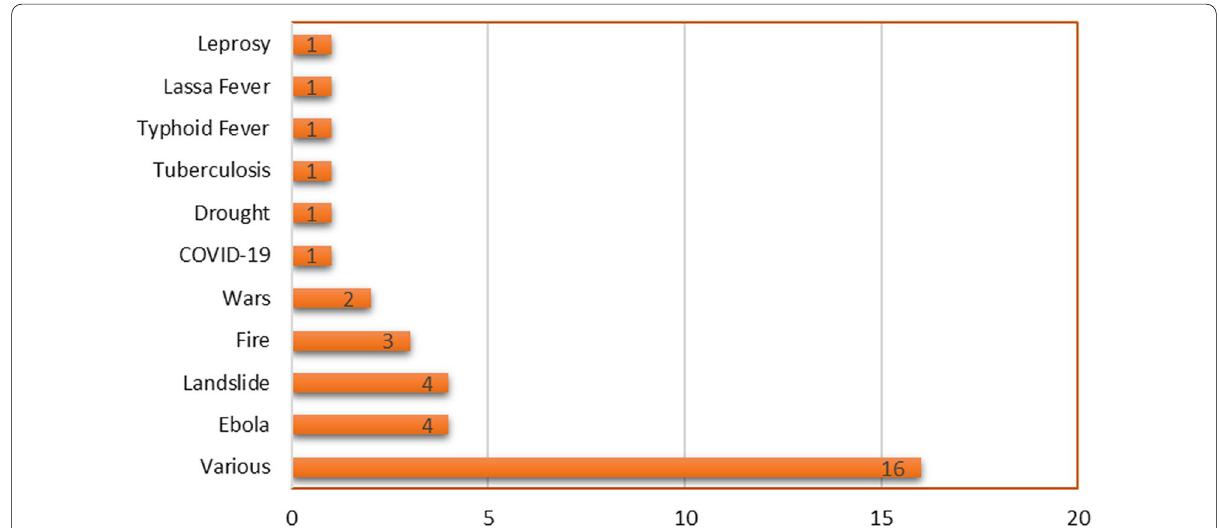
Fig. 1 Disasters investigated by studies on this topic as drawn from the sample. Source